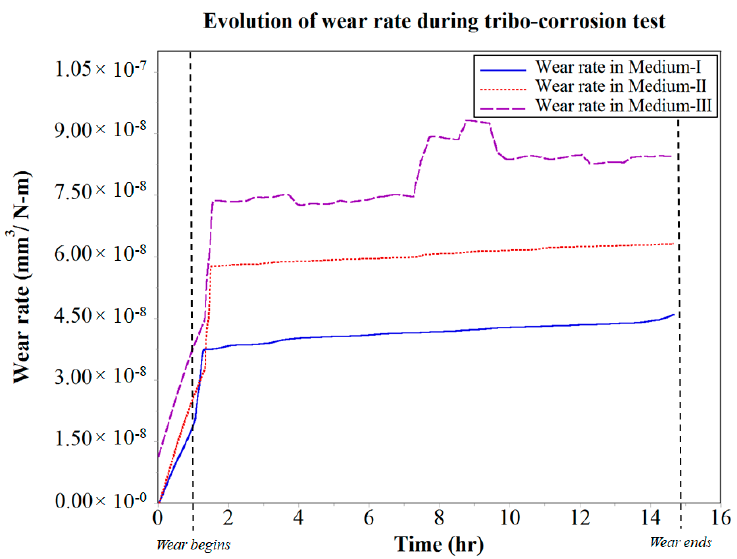
Figure 8. Evolution of wear rate during tribo-corrosion testing.